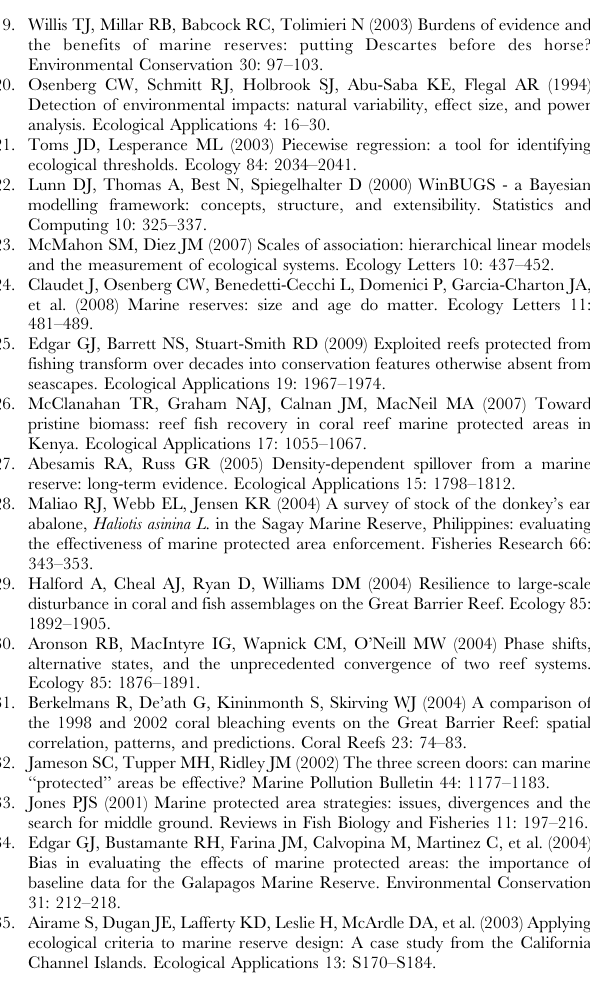
Table S1 R 2 for MPA versus non-MPA model. NA denotes the lack of a predictor for the calculation of R 2 . Table S2 R 2 for MPA-only models in the Caribbean and Indo- Pacific. R 2 can only be calculated at level 1 for these